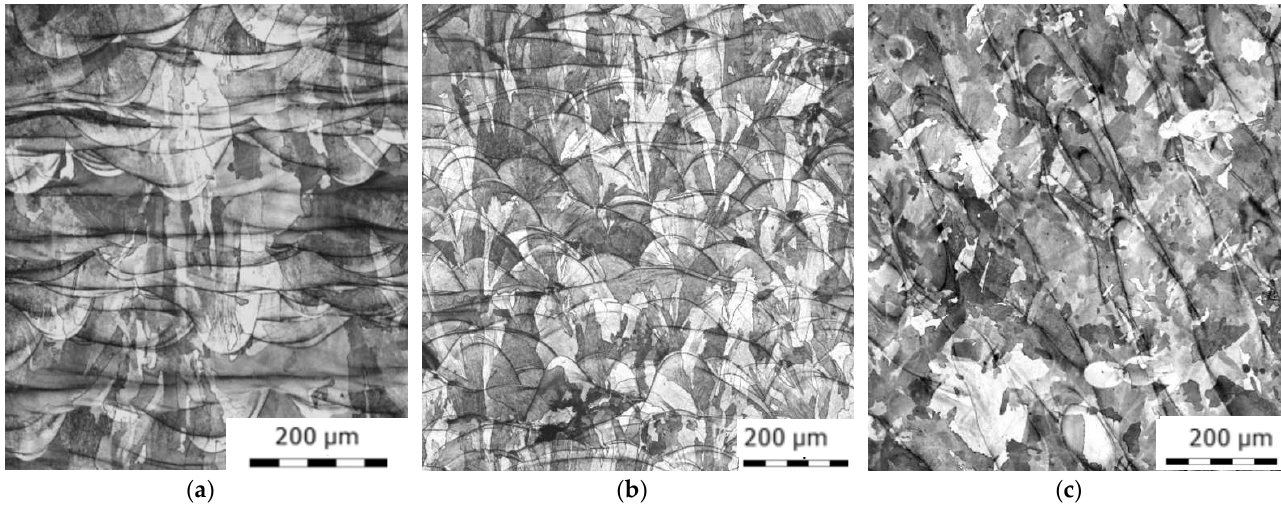
Figure 8. Microstructure of 3D samples: ( a ) surface A; ( b ) perpendicular B; ( c ) parallel C to the printing base.